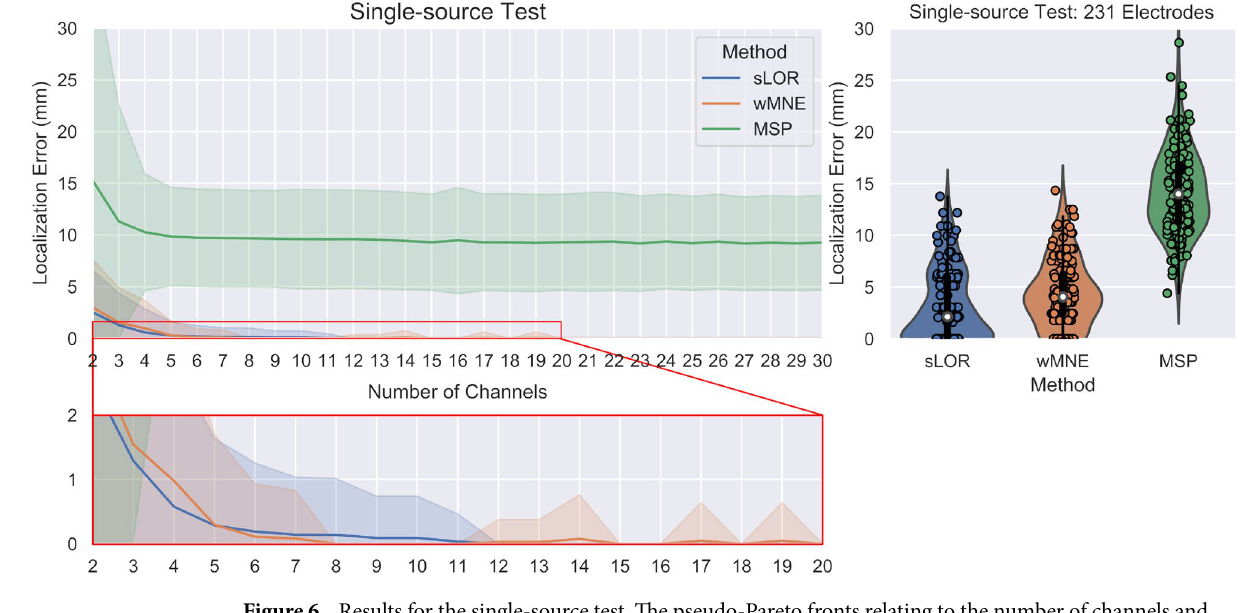
Figure 6. Results for the single-source test. The pseudo-Pareto fronts relating to the number of channels and the localization error by each source reconstruction method are presented at left. The lines represent the mean localization error across the 150 trials and their respective colored bands represent their standard deviation. The mean localization errors across the trials and the standard deviation obtained by using all the electrodes available (231) by each method are presented at right.